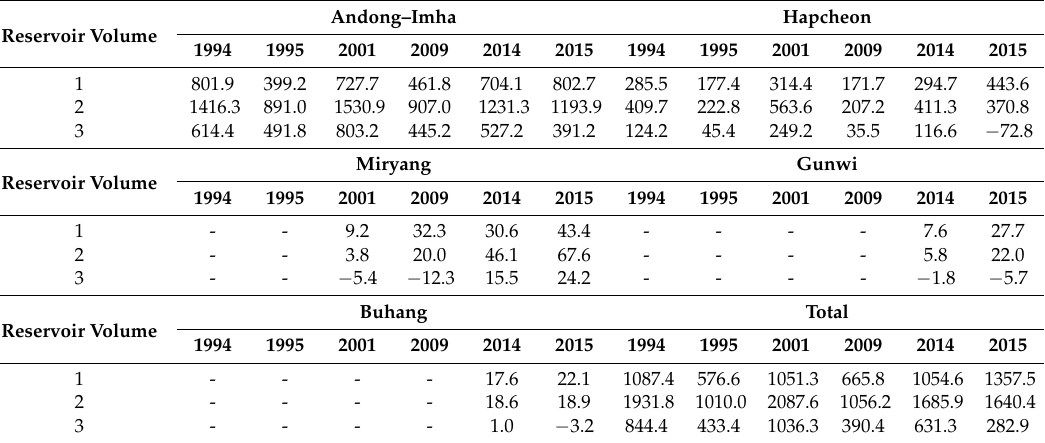
Figure 4. Reservoir volume (m 3 ) results of reservoir operation criteria for six multipurpose dams in the Nakdong River Basin: Past (gray dotted line) and improved (solid black line) operation criteria. Drought stages are presented as normal (Stage 0; green); attention (Stage I; yellow); caution (Stage II; purple); alert (Stage III; pink); serious (Stage IV; red). Extreme drought years are circled in red. Table 4. Evaluation of improved operation criteria of the reservoir for six multipurpose dams on 1 April (Unit: 10 6 m 3 ).